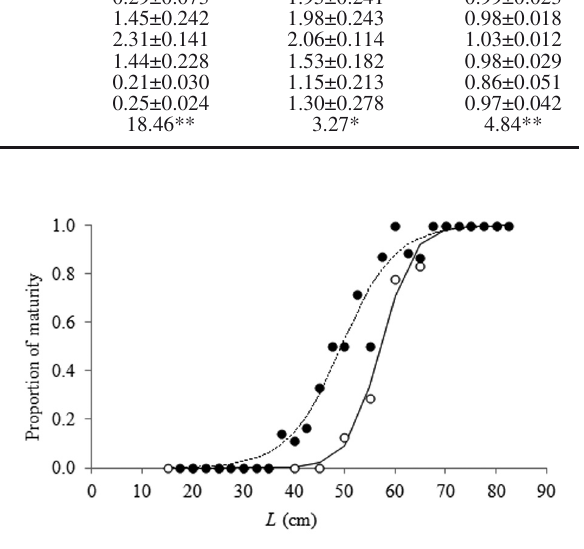
f ig . 6. – Probability curve of maturation of meagre for males ( l ) and females ( ¢